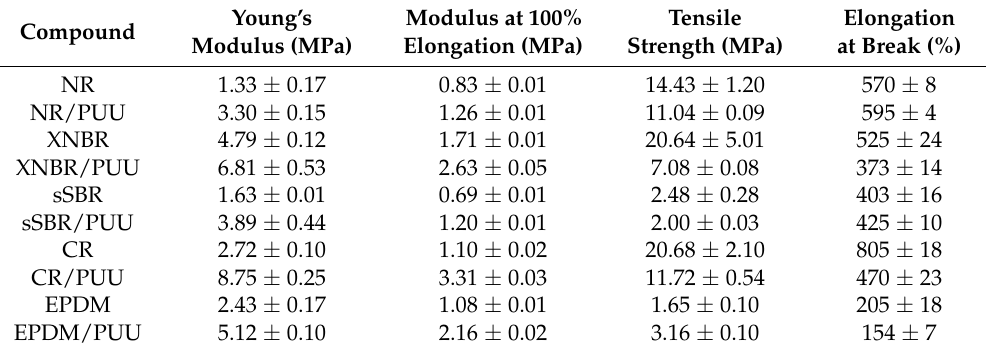
Table 2. Tensile characteristics of neat Rubbers and their Rubber/PUU blends.